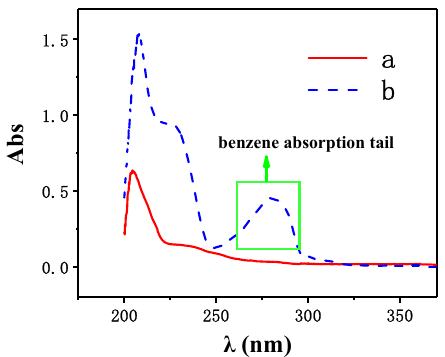
Figure 6. Ultraviolet–visible (UV) spectrum of hydrogenterminated siloxane ( a ) and bio-phenol terminated siloxane ( b ).